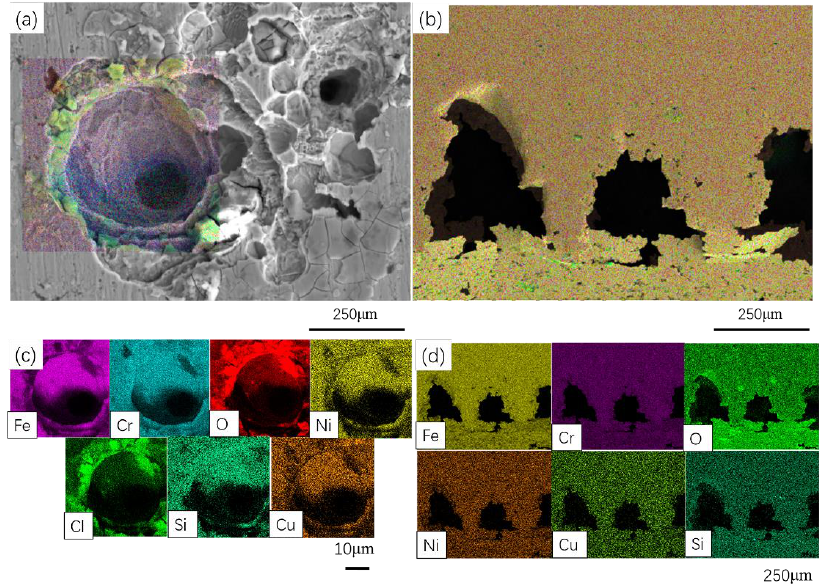
Figure 5. SEM morphology and EDS mapping results of 304Cu ( a , c ) non-penetrating and ( b , d ) pen- etrating pits after 72 h FeCl 3 immersion